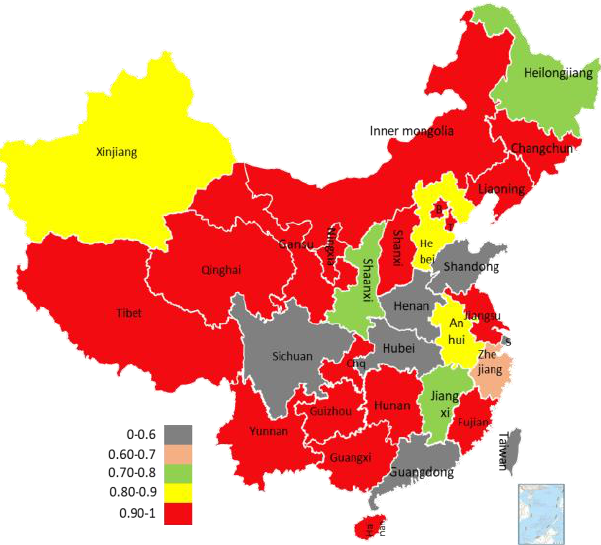
Figure 3. Investment efficiency of the first stage of China's provincial PGEs.